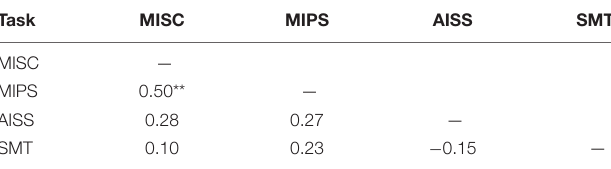
TABLE 3 | Correlations using significant accrual rates only in MIPS and